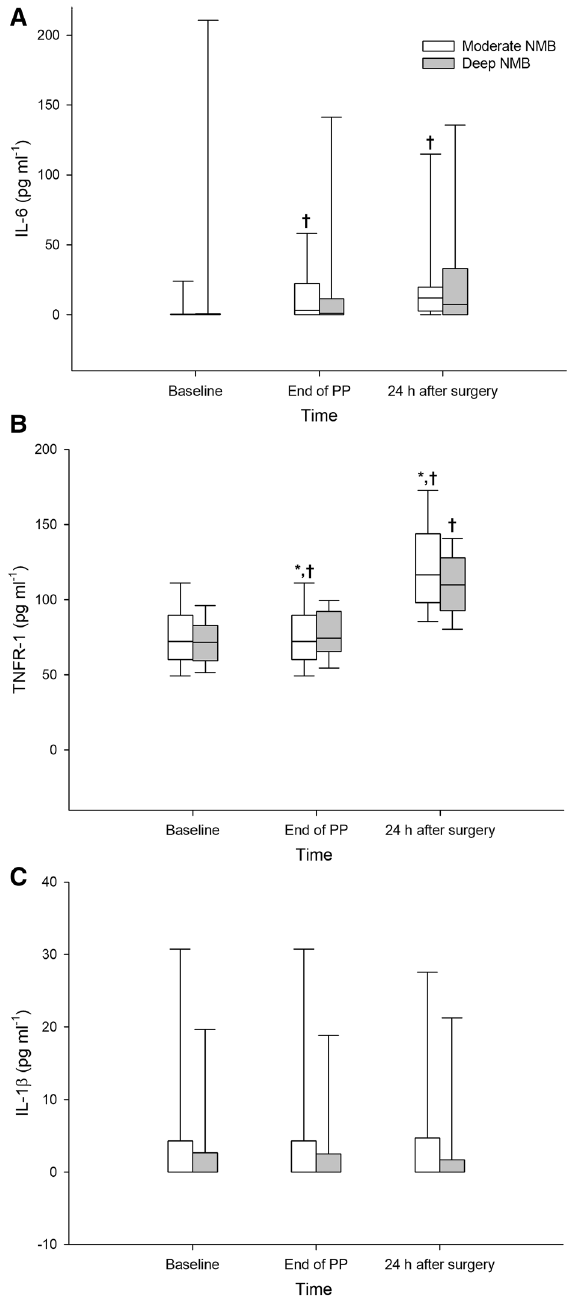
Figure 2. Changes in interleukin (IL)-6 ( A ), tumour necrosis factor receptor (TNFR)-1 ( B ), and IL-1β levels ( C ). Abbreviations: NMB neuromuscular block, PP pneumoperitoneum, Baseline, after anesthetic induction. The box plots represent the median, interquartile range, and 10th and 90th percentile (whiskers). * P < 0.05 between-group comparison. † P < 0.05 versus baseline in each